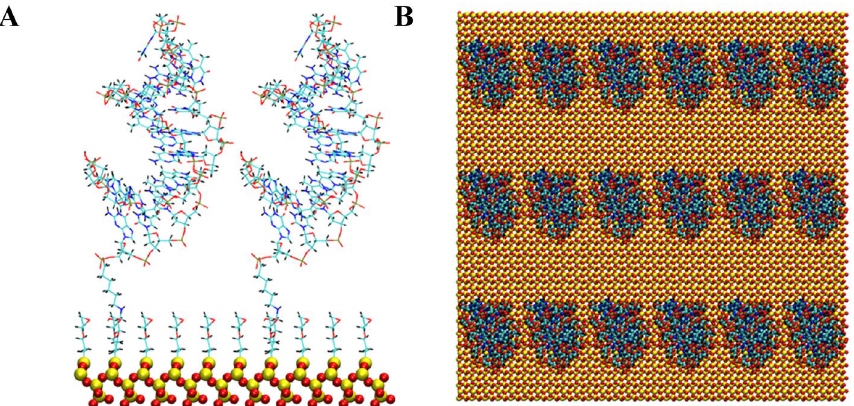
Figure 6. Two anti MUC1 aptamers tethered to SiO 2 biosensor substrate in configuration 5 (3 ′ end attachment, perpendicular to surface, high density) ( A ) Side view of periodic cell ( B ) Top view with periodic display. Water and ion molecules are not displayed.